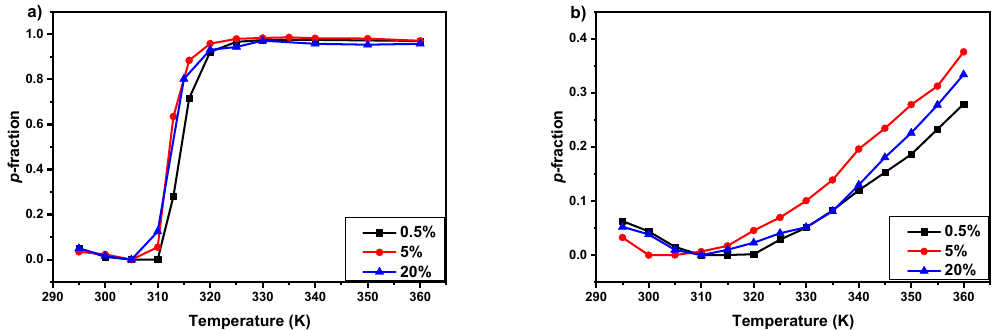
Figure 7. Temperature dependences of the fraction p of PIPOx homopolymer ( a ) and P(MeOx / EtOx)(28 / 72) copolymer ( b ) in D 2 O solutions with three polymer concentrations ( c = 0.5; 5; 20 wt%) during gradual heating.